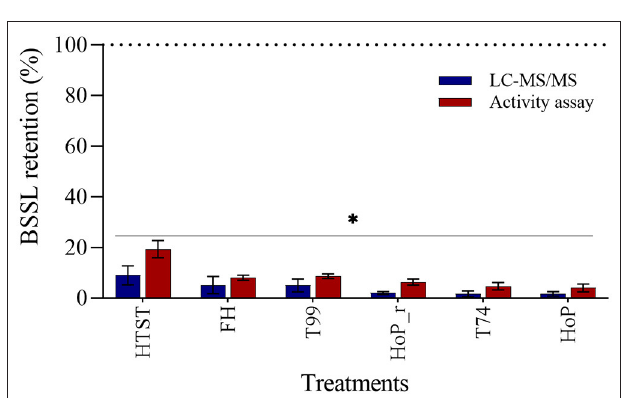
FIGURE 6 | Effect of HTST, FH, T99, HoP_r, T74 and HoP on BSSL levels. BSSL retention (%) was calculated based on the iBAQ intensities and a lipase activity assay. Untreated values were set at 100% (dotted line). The analyses were performed in duplicate for each sample and all values are presented as mean ± standard deviation of two independent experiments. *Expresses statistically significant differences to untreated samples ( p < 0.05). UN, HTST, FH, T99, T74, HoP and HoP_r stand for untreated DHM, and DHM treated with high-temperature short-time, flash heating, high-temperature short-time with a thermomixer preheated at 99 ◦ C, high-temperature short-time with a thermomixer preheated at 74 ◦ C, holder pasteurization and holder pasteurization with rapid heating up-times,